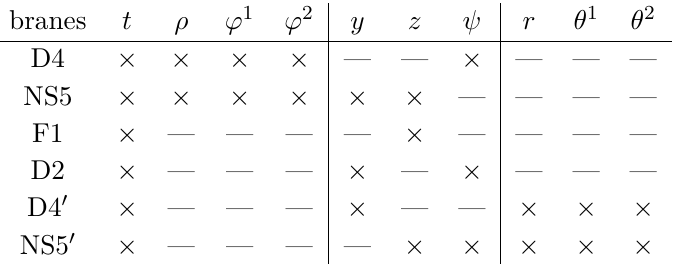
Table 1 . BPS/8 intersection describing F1-D2-D4 0 -NS5 0 branes ending on a D4-NS5 bound state. This system defines a N = 4 line defect SCQM within the N = 2 4d CFT living in the D4-NS5